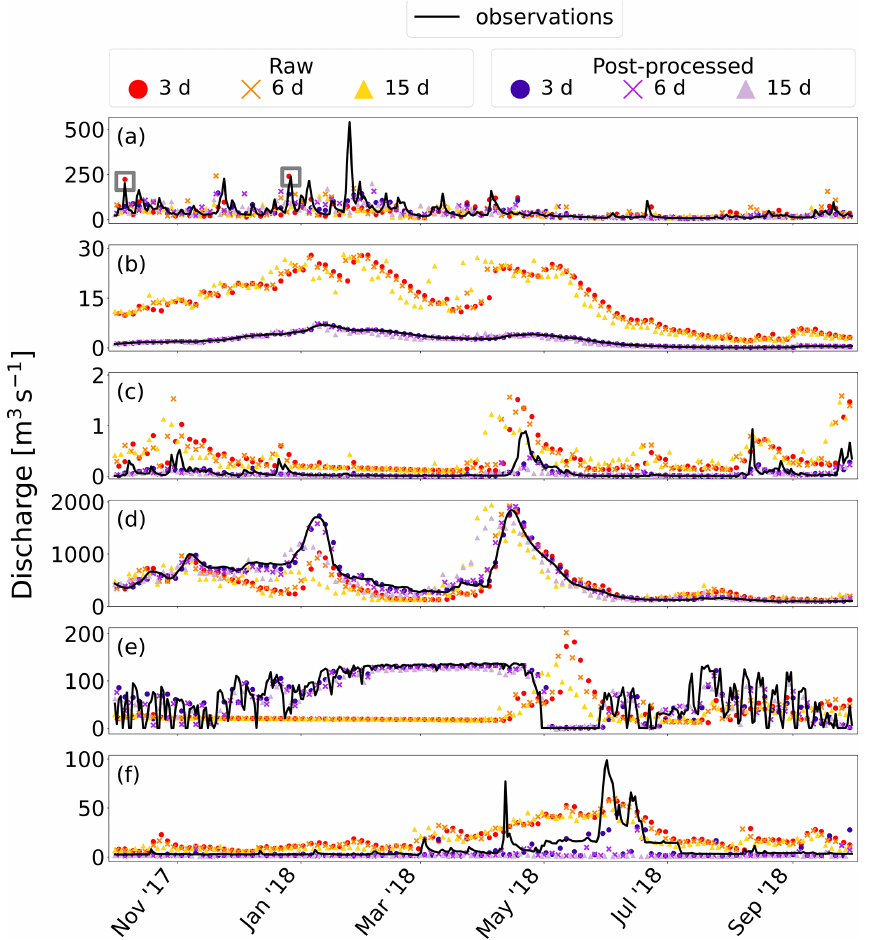
Figure 11. Observation time series for 1 year of the evaluation period from October 2017 to October 2018 for six example stations. The forecast medians of the raw and post-processed forecasts are shown for lead times of 3, 6, and 15d. (a) Daldowie, Scotland. (b) Nytorp,